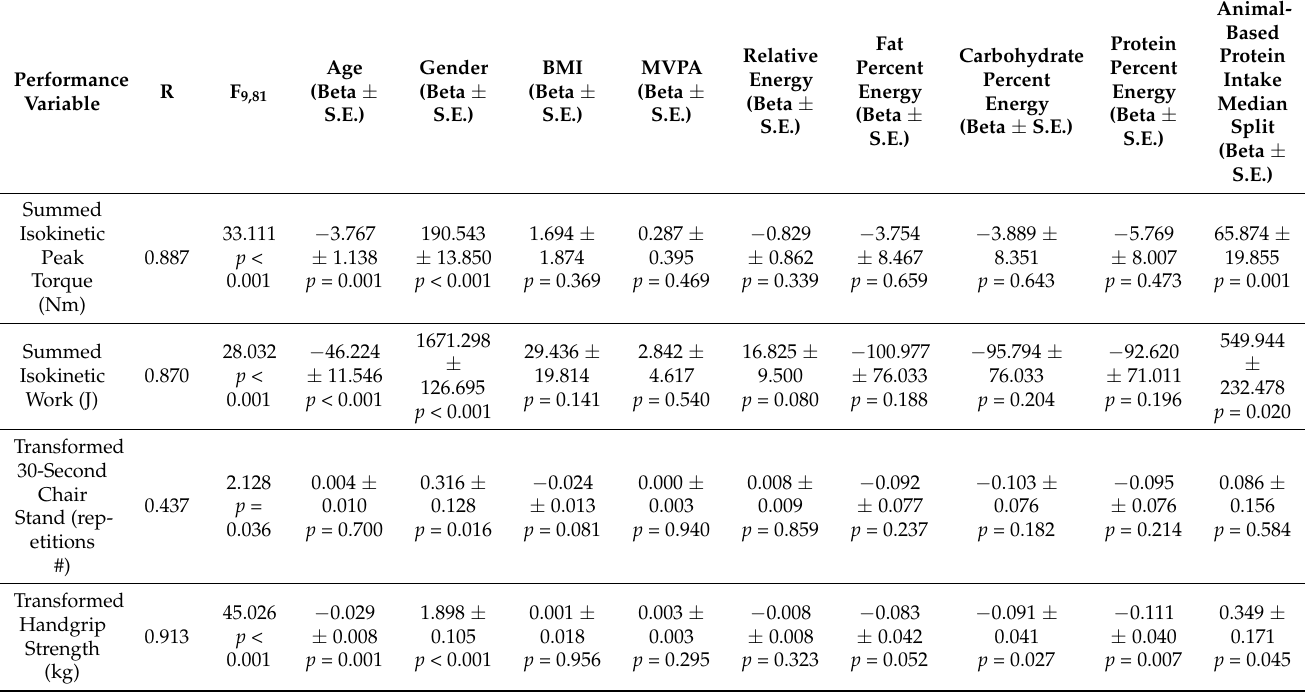
Table 8 and Figure 2 present the results of our investigation of the relationship between ABPI with performance measures. To create homoscedastic models with equal variances, data from the handgrip strength test (kg) and the 30-s chair stand test (repetitions) were transformed using the square root function. Using these transformed variables, all of these mixed models had equal variances according to Levene’s Test and were homoscedastic according to White’s test (i.e., p > 0.05). Table 8. Animal-based protein intake and muscular performance in middle-aged men and